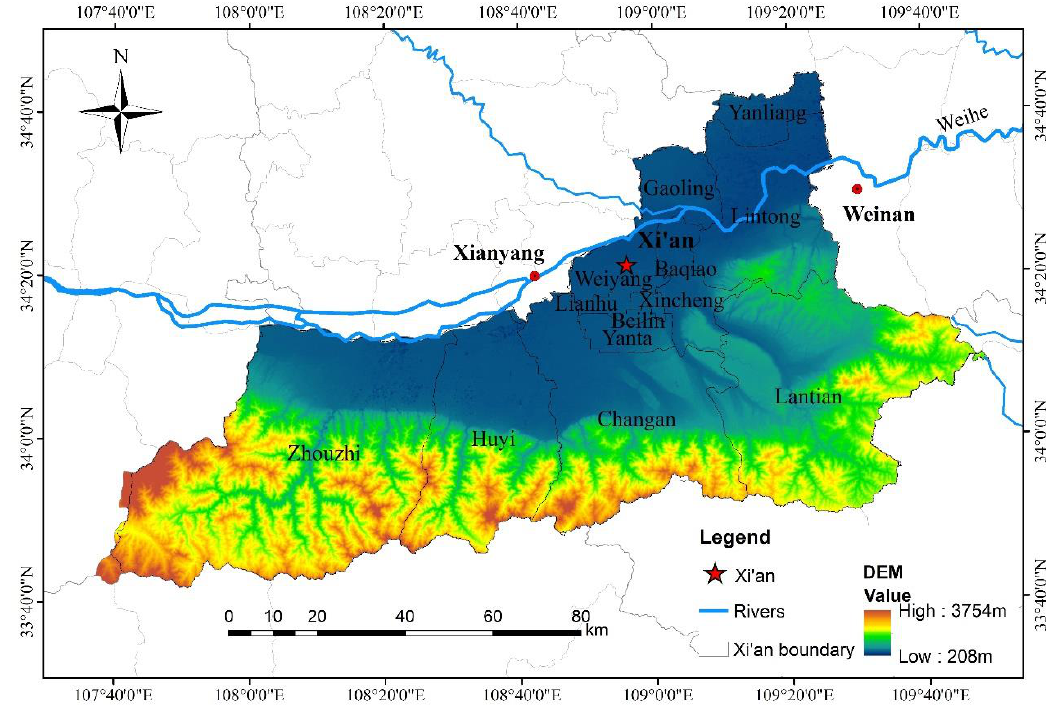
Figure 1. The location map of study area.